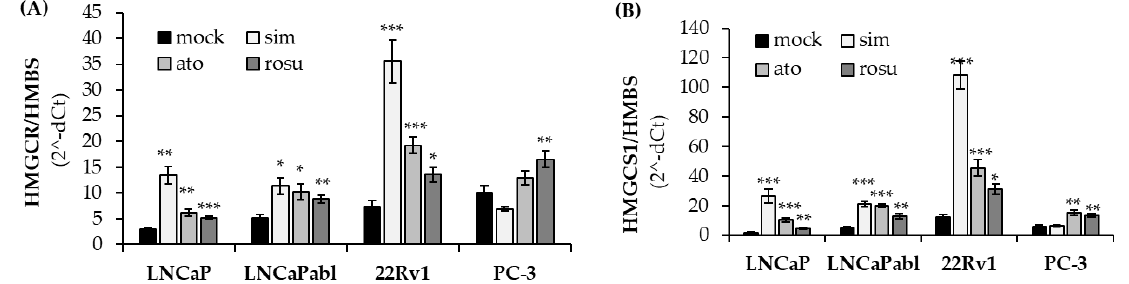
Figure 2. Expression of HMGCR ( A ) and HMGCS1 ( B ) after treatment with statins (5 µM) was determined via real-time qPCR and normalized to the housekeeping gene hydroxybilane synthase ( HMBS ). Data are represented as mean ± SEM. (* p < 0.05, ** p < 0.01, *** p <